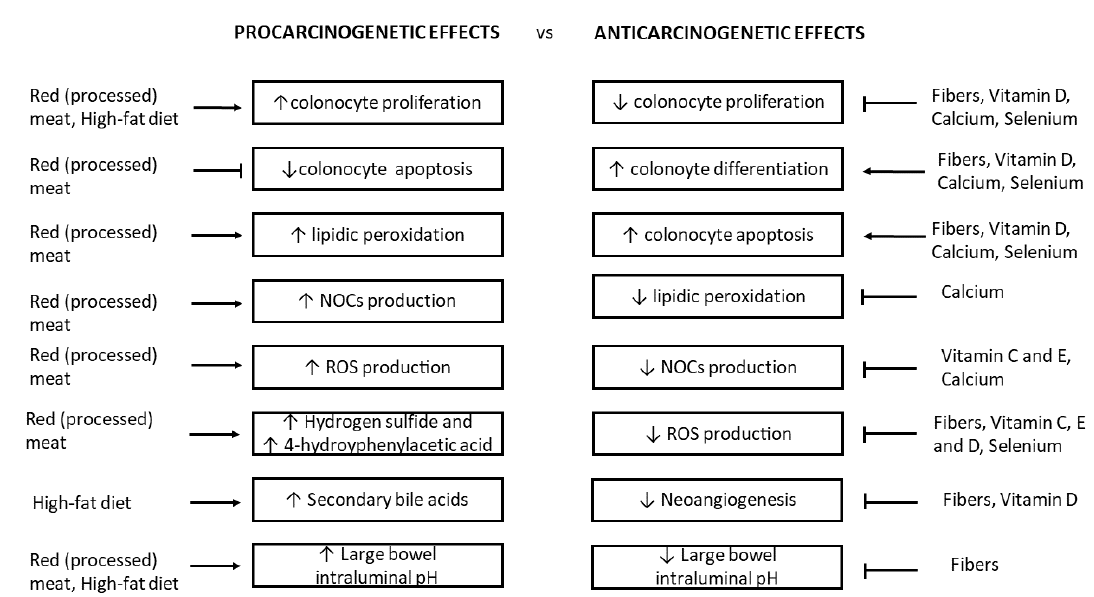
Figure 1. Schematic representation of the mechanisms of specific dietary components in improving or contrasting the carcinogenic processes on large bowel mucosa. ↑: increase; ↓ : reduction.